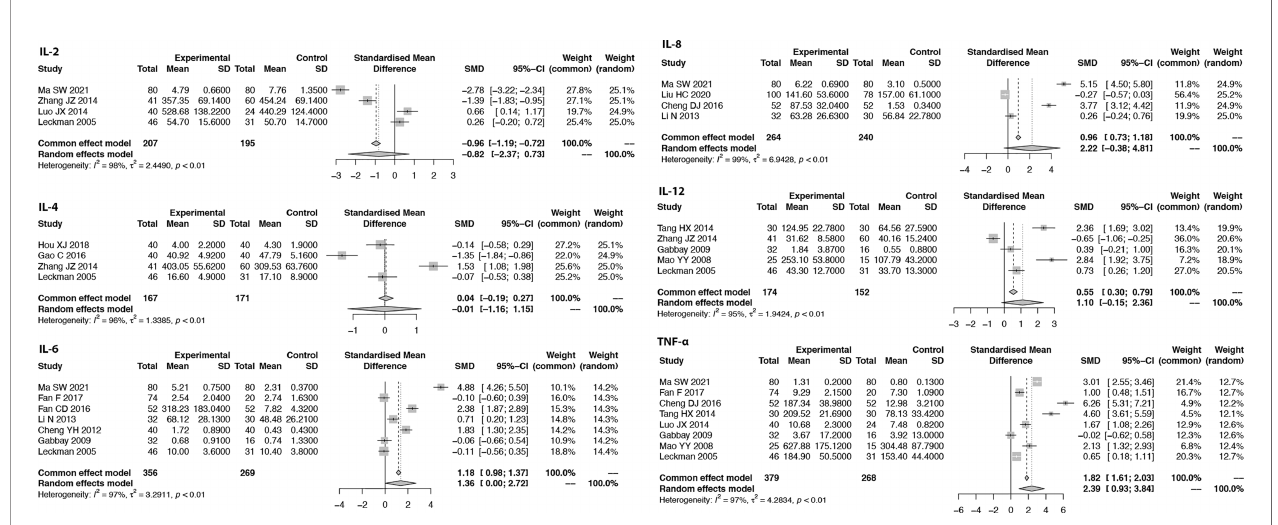
FIGURE 3 | Forest plots of the meta-analysis of proin fl ammatory cytokines.